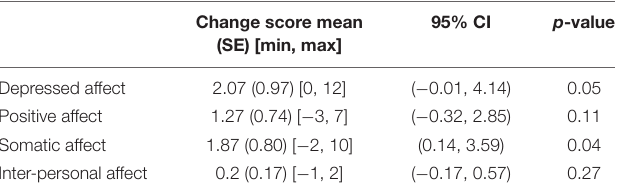
TABLE 4 | Analysis of change scores (pre-post) for CES-D subscales in acromegaly patients ( n = 15).